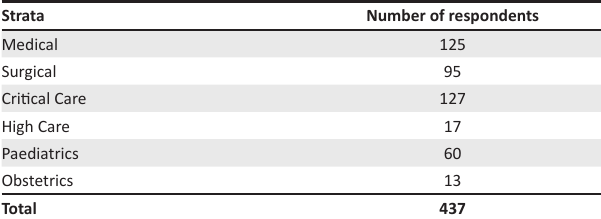
TABLE 2: Distribution of respondents.